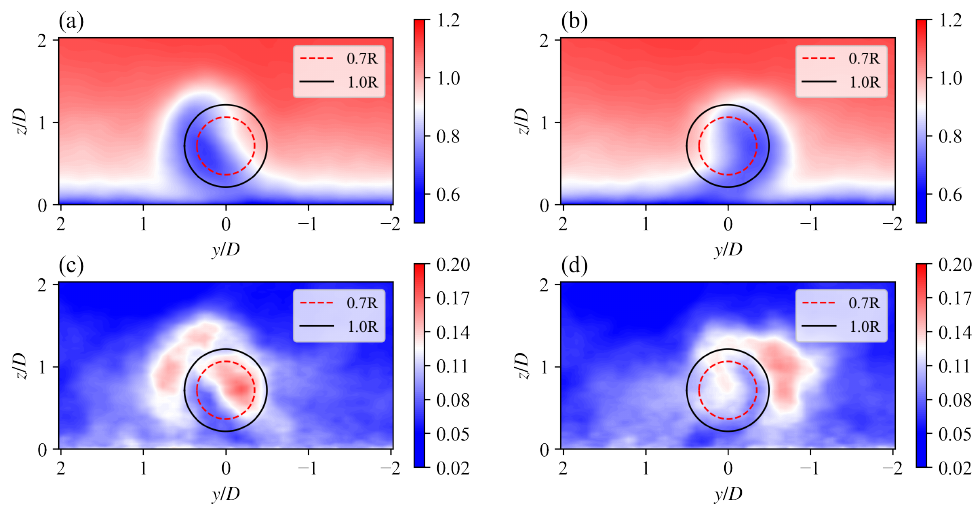
Figure 14. Front-view y - z cross-section contours of normalised streamwise mean velocity and turbulence intensity, I u , at the location 6D downwind of WT 1: ( a ) u / u in , γ 1 = − 25 ◦ ; ( b ) u / u in , γ 1 = 25 ◦ ; ( c ) I u , γ 1 = − 25 ◦ ; and ( d ) I u , γ 1 = 25 ◦ . The black and red circles represent the trajectories of the blade sections r = 1.0 R and r = 0.7 R of the rotating blade,